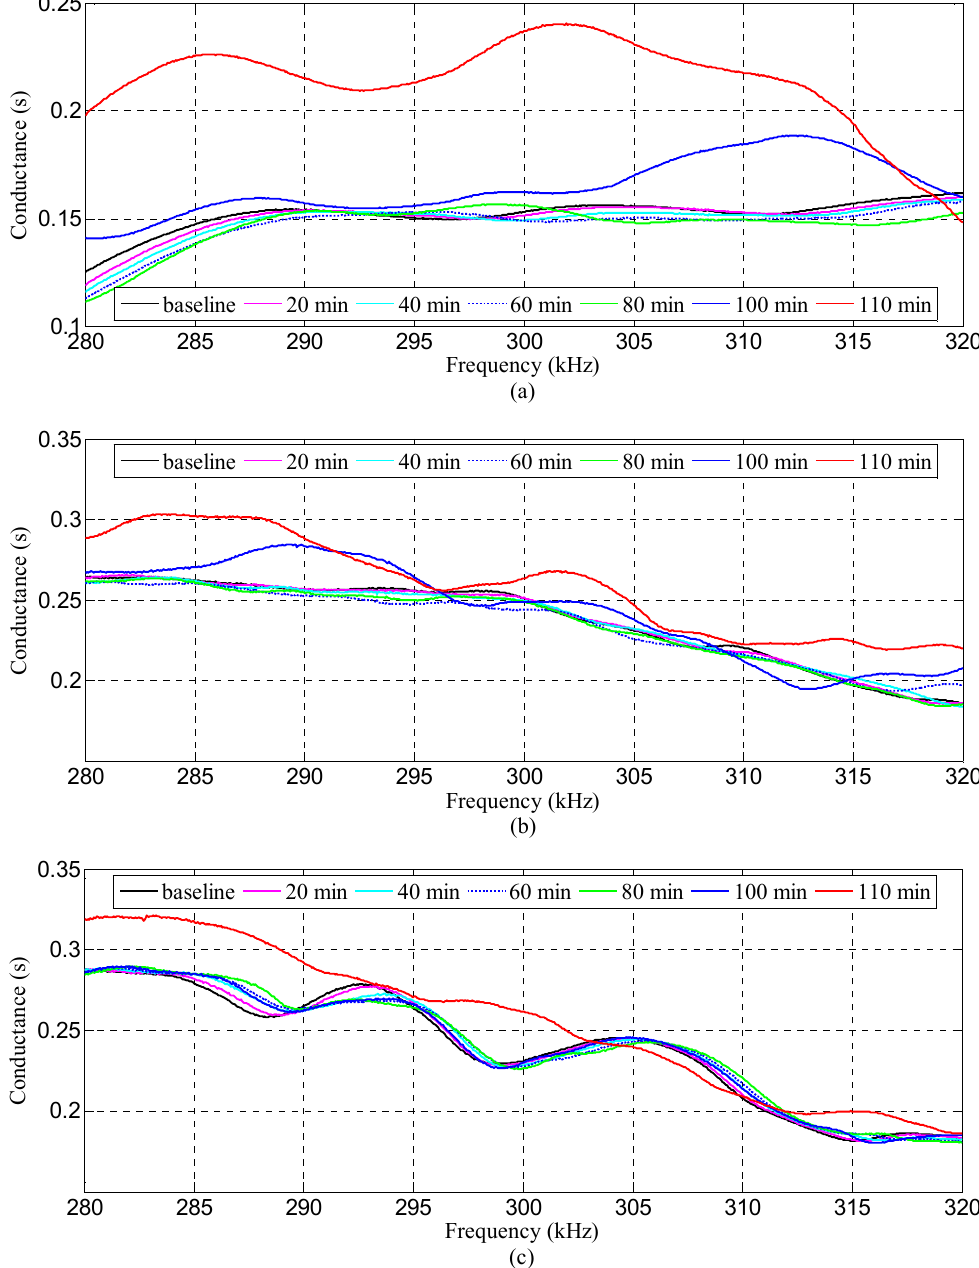
Figure 7. Conductance spectra of the three SAs in specimen S1. ( a ) SA-1, ( b ) SA-2, ( c ) SA-3.